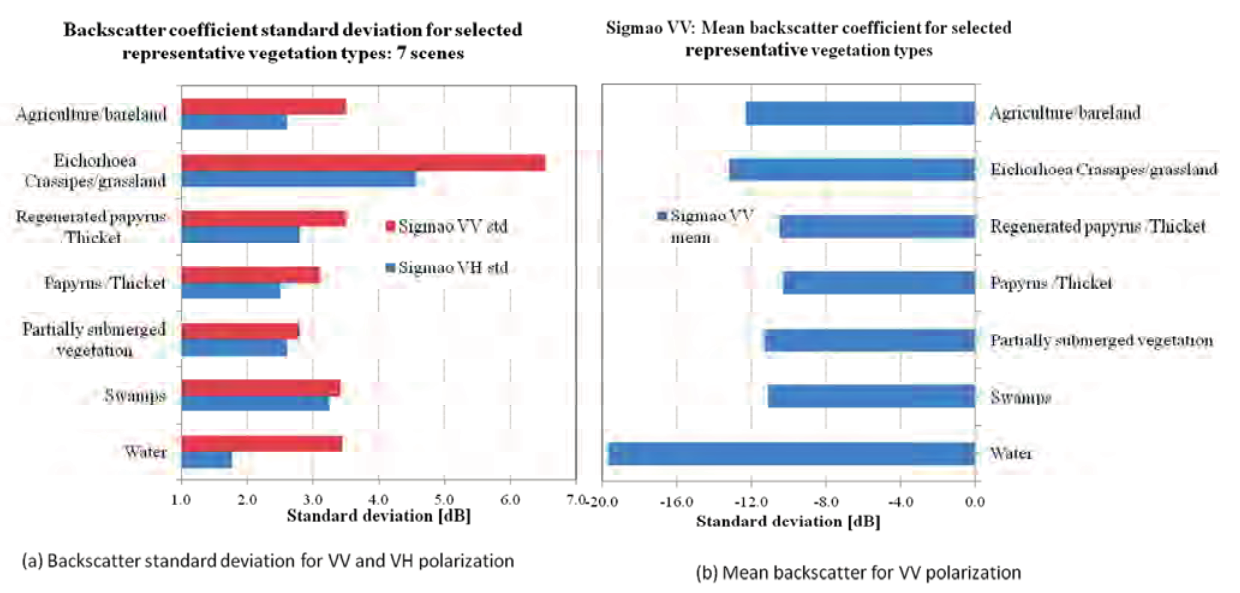
Figure 8. Backscatter statistics for different vegetation types for ( a ) Standard deviation (std) for VV and VH polarization ( b ) Mean for VV polarization. Sigmao represents σ °. Sigmao VV std is standard deviation of VV polarisation; Sigmao VV mean is average of VV polarisation and Sigmao VH std is standard deviation of VH polarization for the selected seven